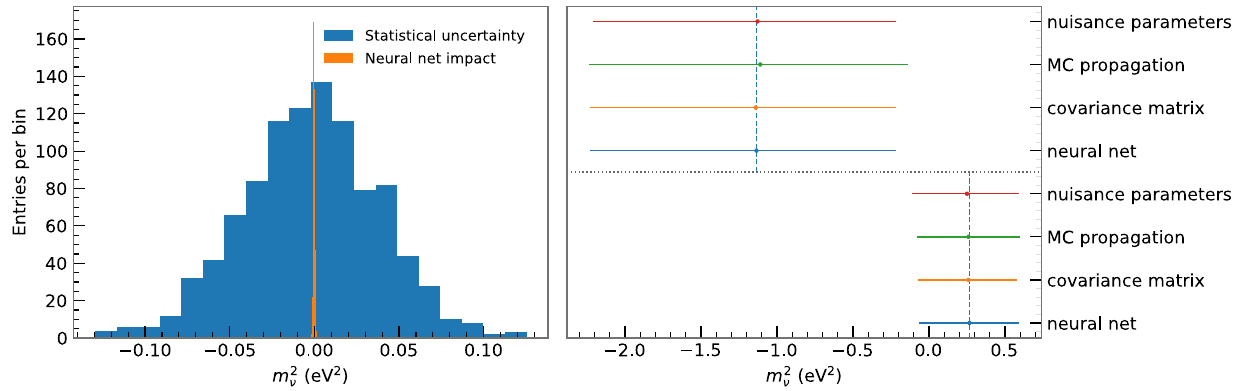
Fig. 5 Left: difference of best-fit m 2 ν values using the regular analysis framework and our neural network (orange) compared to the assumed statistical uncertainty of 0.04eV 2 on our 1000 day Monte Carlo spec- trum. Both bias ( − 3 × 10 − 4 eV 2 ) and width (4 × 10 − 4 eV 2 ) are below